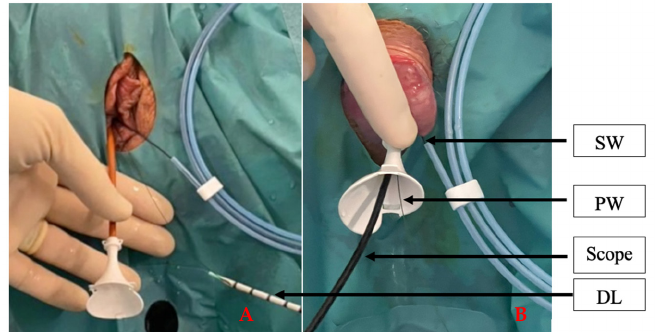
Figure 3. ( A ) Placement of PressureWire after the use of a dual lumen ureteral access catheter (Cook Medical, Germany). ( B ) PressureWire was placed through the UAS (Retrace 10/12, 35 cm, Coloplast, Denmark) with a digital reusable flexible ureterorenoscope (Flex-XC, 8.5Fh, Storz, Germany) inside. SW, safety wire. PW, PressureWire. DL, dual lumen.